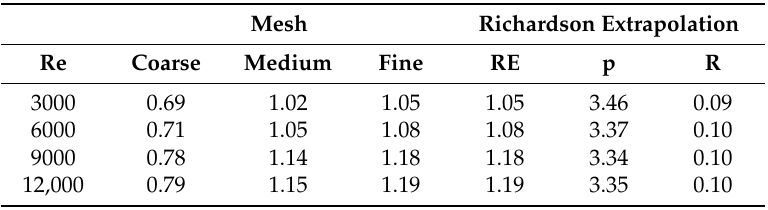
Table 1. Results of the mesh independency